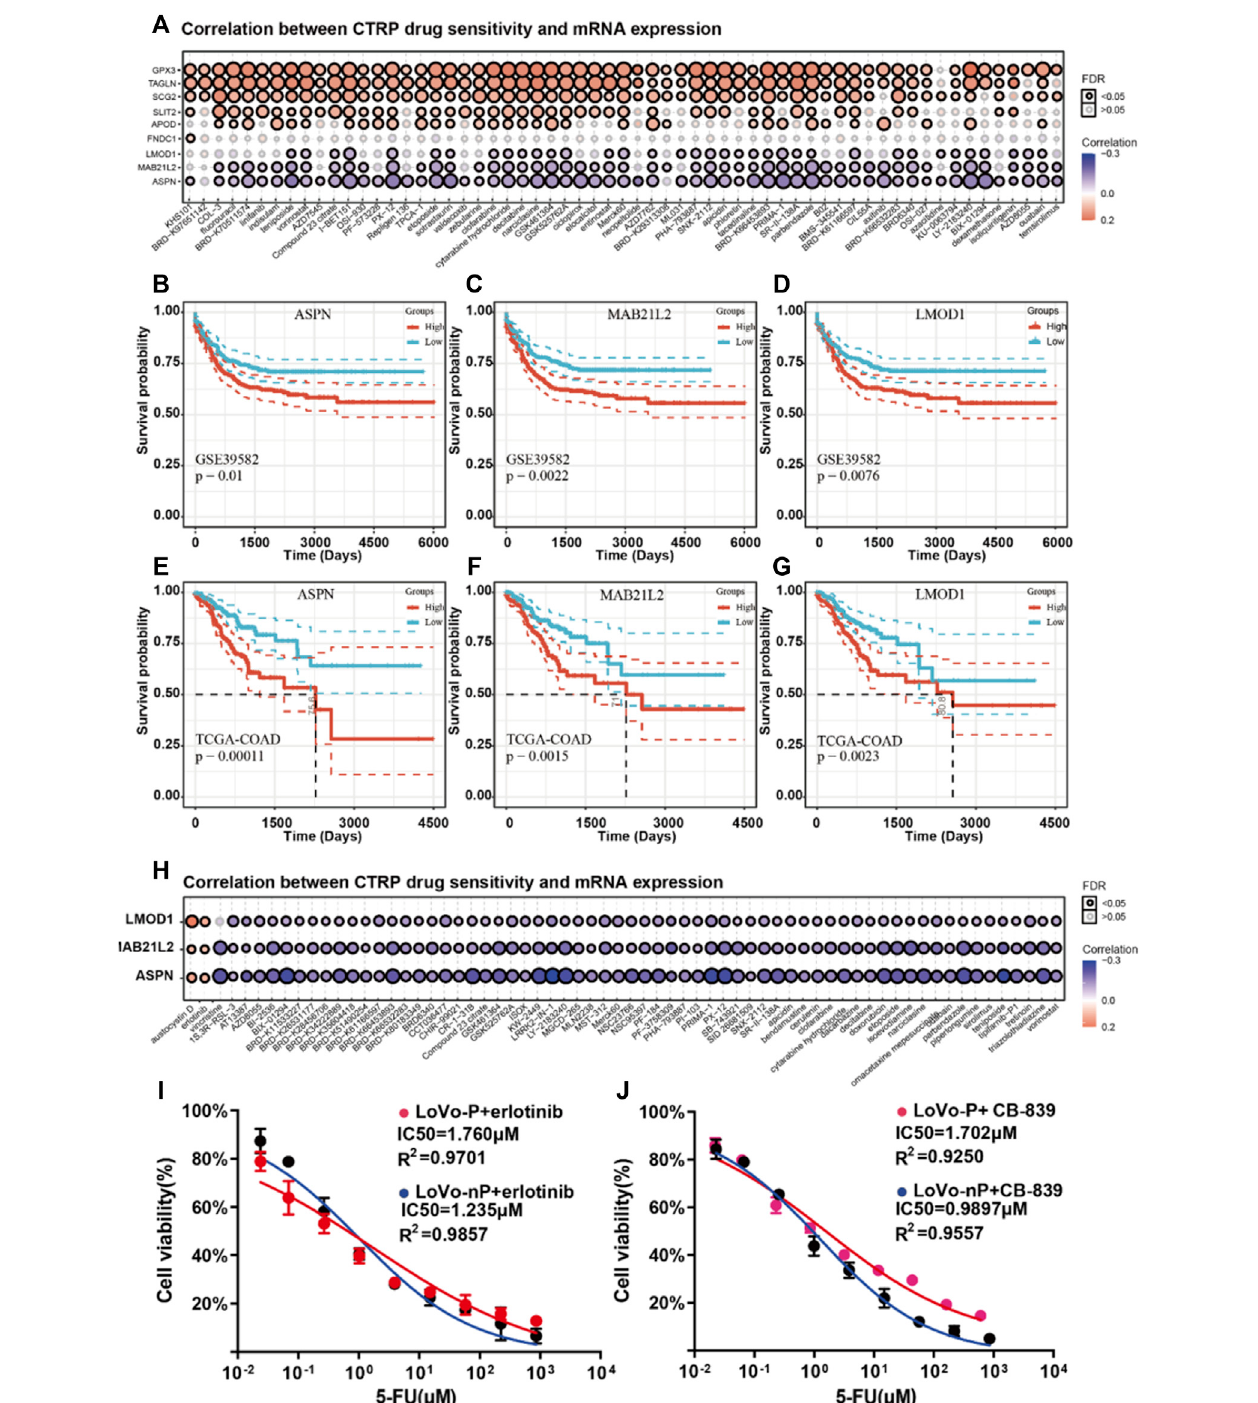
FIGURE5|(A) CorrelationanalysisbetweenmRNAexpressionofnineprognosis-relatedgenesandCTRPdrugsensitivity. (B – D) Recurrence-freesurvival(RFS)of ASPN, LMOD1, and MAB21L2 in GSE39582. (E – G) Progression-free survival (PFS) of ASPN, LMOD1, and MAB21L2 in GSE39582. (H) Correlation analysis between mRNA expression of ASPN, LMOD1, and MAB21L2 and CTRP drug sensitivity. (I-J) IC50 of 5-FU between DTP cells (LoVo-P and RKO-P) and parental cells (LoVo-nP and RKO-nP) cultured with erlotinib (2 µM) and CB-839 (2 µM).